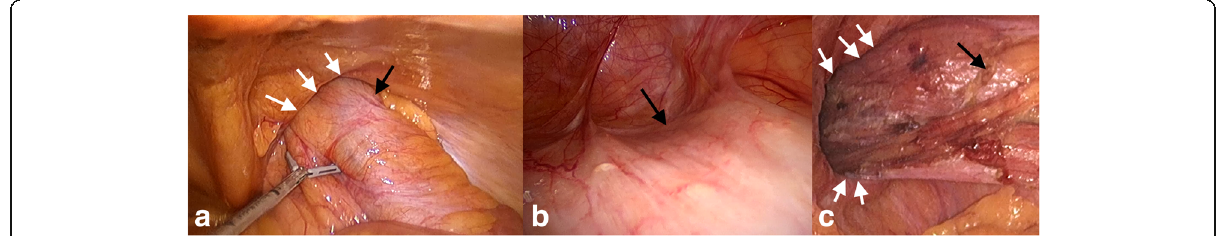
Fig. 3 Intra-operative images. a Laparoscopic view of ascending colon (black arrows) herniating through the deep ring (white arrows). b Angled view within the hernial sac (inguinal canal) using the 30° laparoscope, black arrows pointing to adherent ascending colon. c Laparoscopic view of the deep ring (white arrows) with ascending colon (black arrows) and terminal ileum